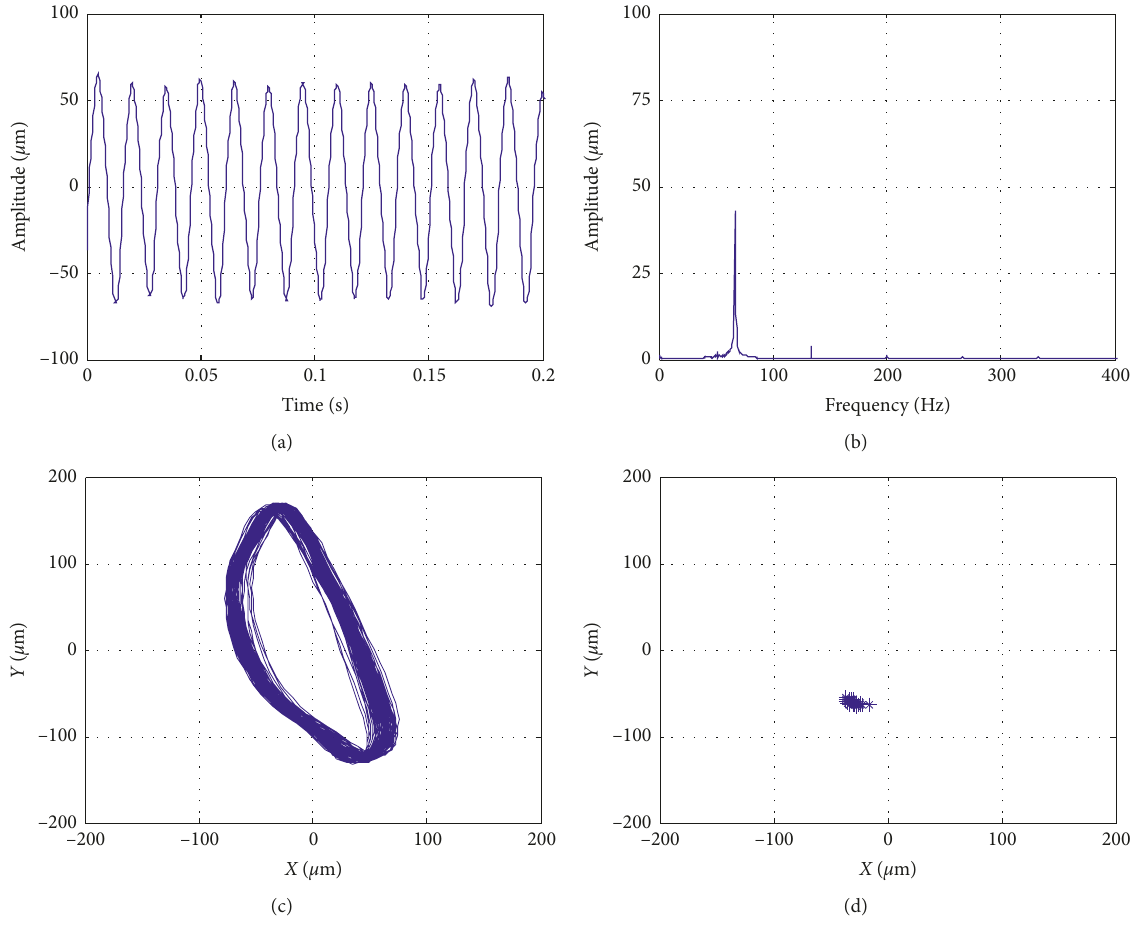
Figure 12: Local slight rubbing at 4000r/min. (a) Time-domain waveform. (b) Spectrum graph. (c) axis orbit. (d) Poincare